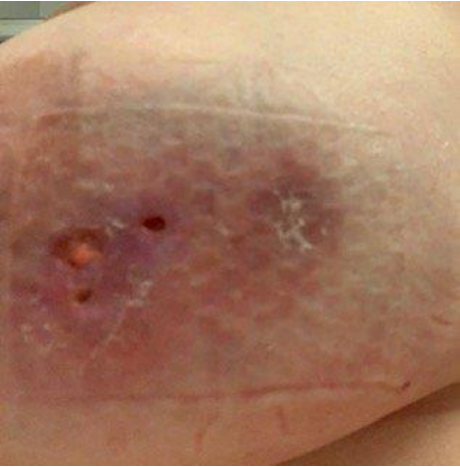
Figure 2. Left lateral breast with 5 cm oval erythematous indurated plaque with firm palpable sub- cutaneous tissue. Three overlying 2 – 5 mm round ulcerations, one with adherent yellow fibrinous subcutaneous tissue. Three overlying 2–5 mm round ulcerations, one with adherent yellow fibrinous debris at the base. debris at the